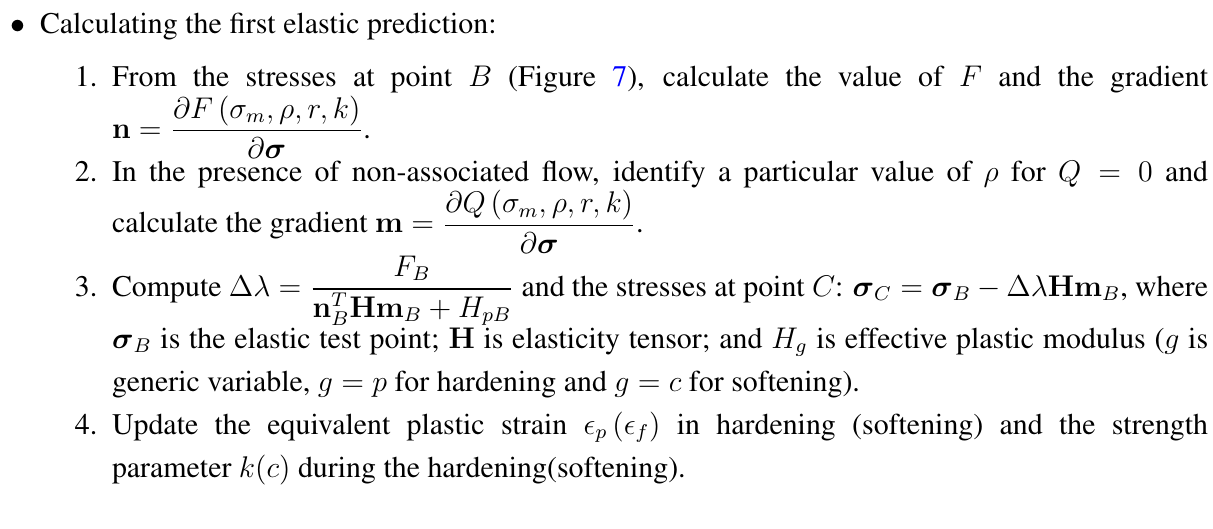
Figure 7. Predictor Elastic test